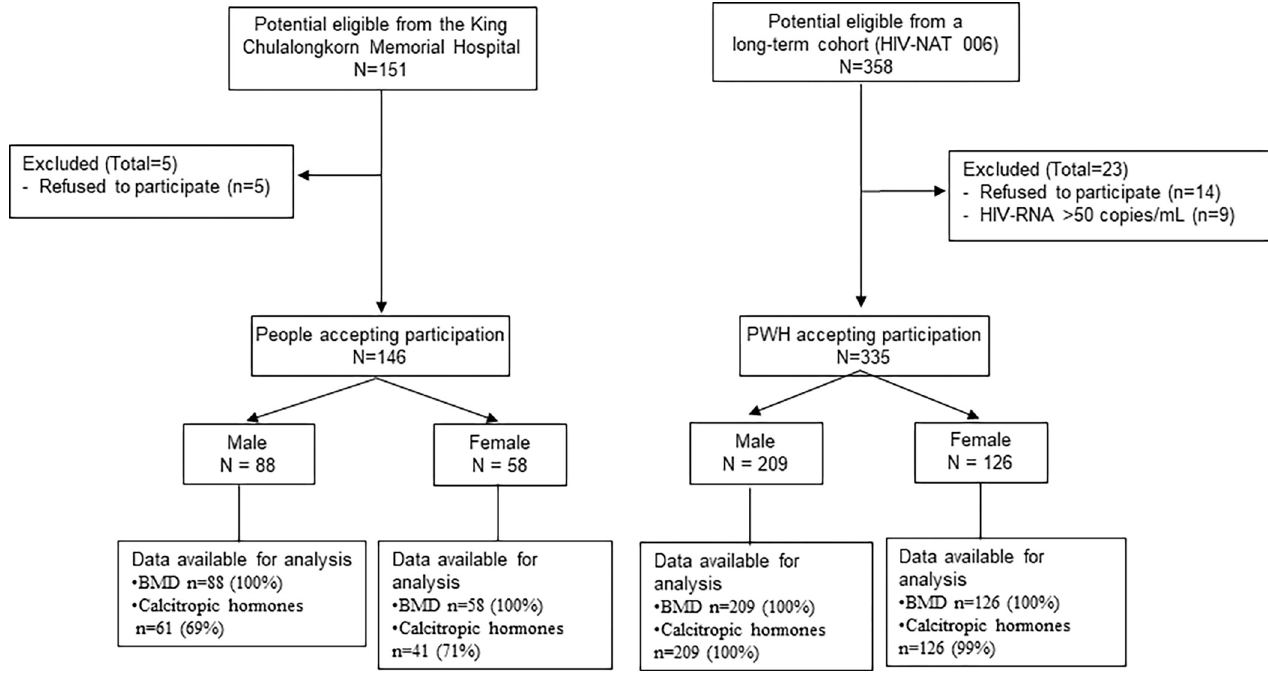
Fig 1. Participants recruitment and investigation flow